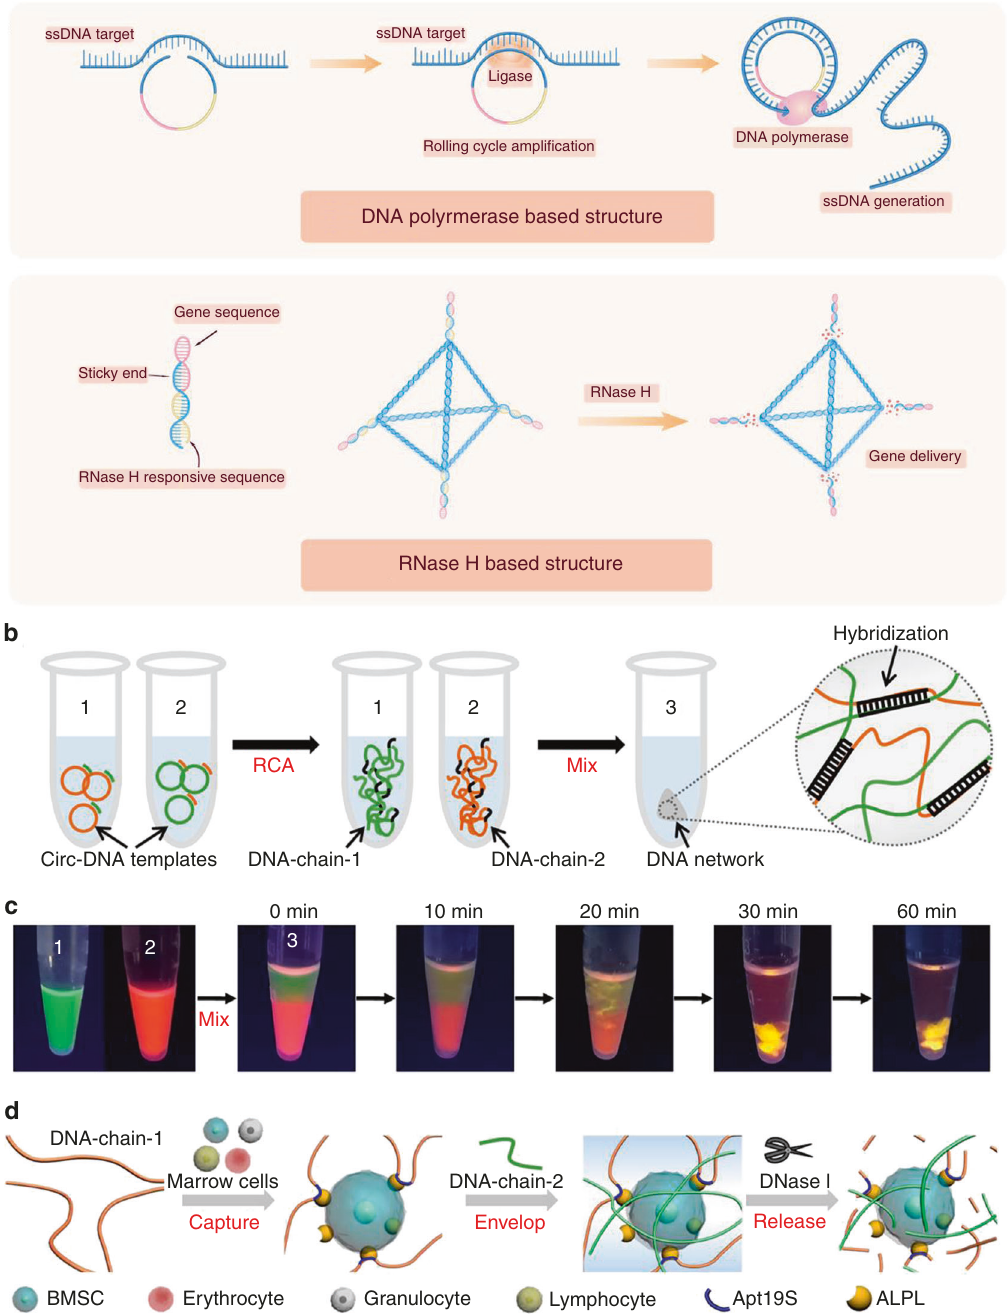
Fig. 4 Dynamic DNA structures based on proteins or other substances. a Schematic illustration of dynamic DNA structures based on proteins. b Synthetic process of ultralong DNA chains via RCA to obtain a 3D DNA network. c Mix of DNA chains to visualize the molecular diffusion and phase inversion during the formation of a DNA network. DNA-chain-1 and DNA-chain-2 were stained with SYBR Green II and Gel Red, respectively. d The process of capture, envelopment, and release: (1) capture, DNA-chain-1 was incubated with BMSCs for cell capture by anchoring to the aptamer Apt19S; (2) envelopment, DNA-chain-2 was added to the cell-containing DNA-chain-1 solution to trigger the formation of the DNA network; and (3) release, the DNA network can be digested by the nuclease DNase I to release BMSCs. 152